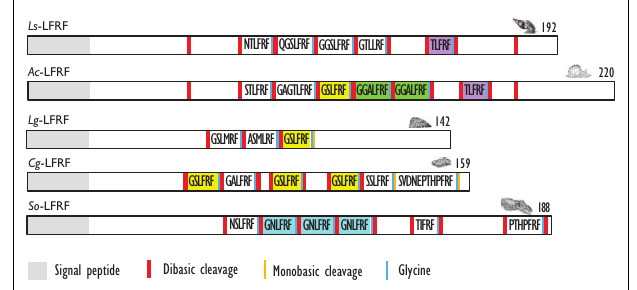
FIGURE 3 | Comparison of the linear schematic organization of LFRFa precursors in mollusks: Ls -LFRF identified in Lymnaea stagnalis (88), Ac -LFRF in Aplysia californica (86), Lg -LFRF in Lottia gigantea (27), Cg -LFRF in Crassostrea gigas (87), and So-LFRF in Sepia officinalis (91) . Signal peptides, proteolytic processing sites, and C-terminal glycines for amidation are indicated by distinct labels.